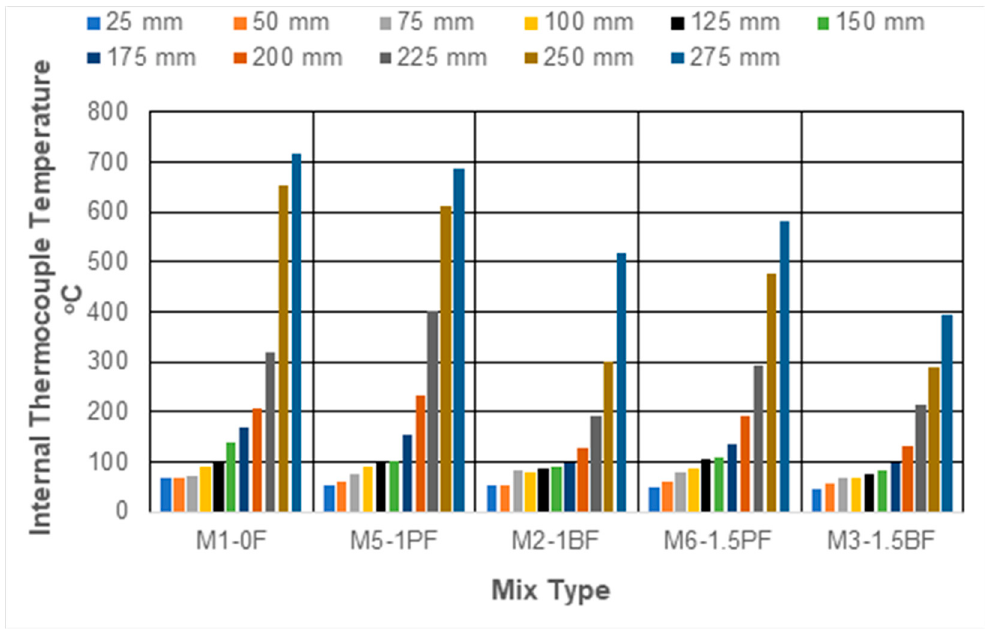
Figure 8. Temperature measurements of internal thermocouples installed at different depth of the slab at the end of 120 min of fire exposure (275 mm thermocouple is nearest to the fire).